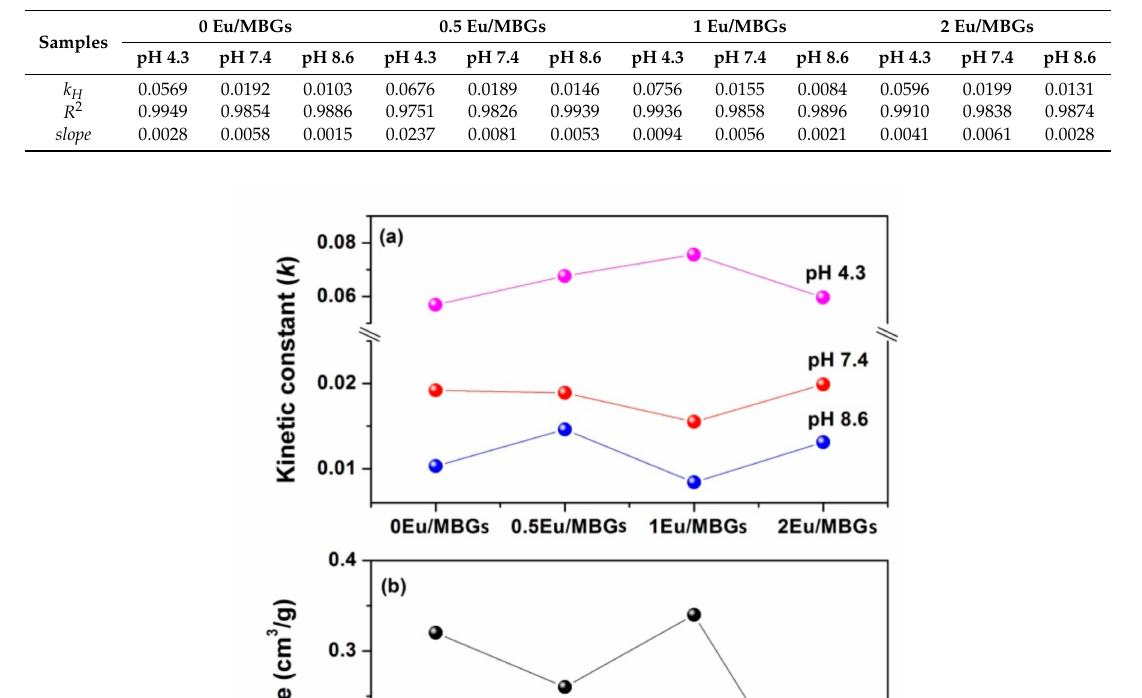
Table 3. The kinetic constant ( k H ), coefficient of determination ( R 2 ) and slope of linear regression values of DOX release from Eu/MBGs with different pH values in vitro.